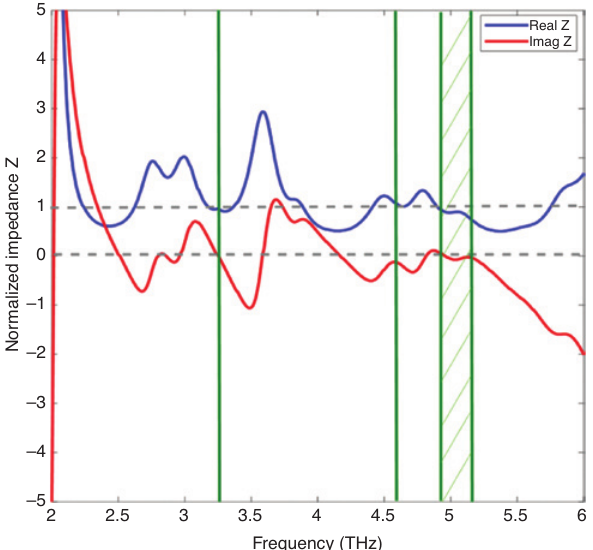
Figure 7: Normalized effective impedance spectrum of the broadband supercell at 11 μ m. The dashed gray lines mark the impedance with amplitude 1 and 0, and the solid green lines mark the resonance frequency with maximum absorption.